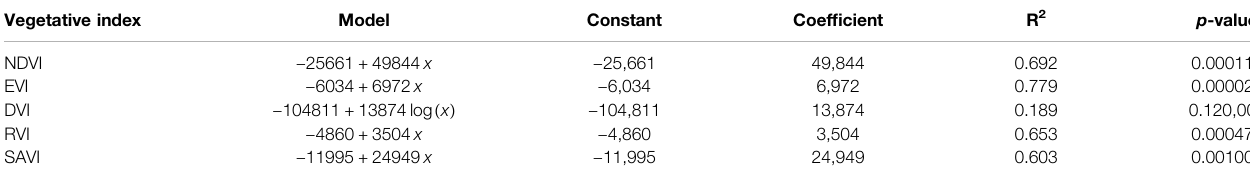
TABLE 7 | The regression model applied to estimate carbon stock in institutional parks (IP). Vegetative index